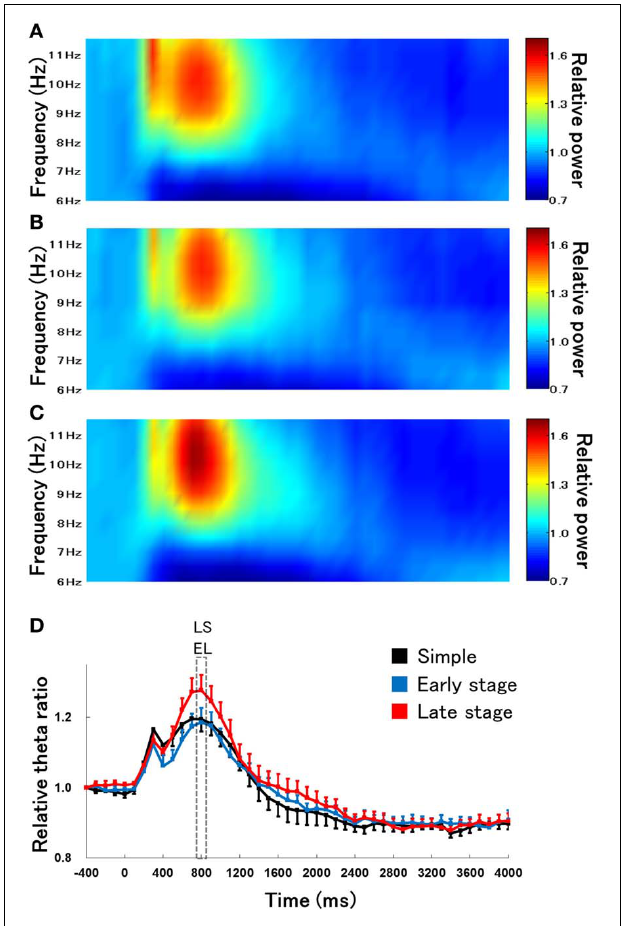
FIGURE 5 | The relative change in hippocampal theta power during non-RFTs of the retention test for the simple discrimination task (A), the early learning stage (B), and the late learning stage (C) of the FN task. The 0-ms period indicates the onset of the stimulus presentation. The X-axis is time (ms) and the Y-axis is frequency (Hz) in panels (A–C) . The period was divided into 45 sub-periods of 100ms each. The mean hippocampal theta power from 500 to 400ms before the stimulus onset was counted as the − 400-ms period (no stimuli were present and no rats pressed the lever during this period), and the relative theta power calculated for each period was normalized to that of the − 400-ms period (relative theta power of each period = theta power of each period/theta power at the − 400-ms period). Panel (D) depicts the mean hippocampal theta power between 6 and 12Hz (Simple: simple discrimination task; Early stage: early learning stage of the FN task; Late stage: late learning stage of the FN task). The “ES” indicates a significant difference between the early learning stage of the FN task and the retention test for the simple discrimination task (ES: p < 0 . 05 ), “EL” indicates a significant difference between the early learning stage and the late learning stage of the FN task (EL: p < 0 . 05 ), and “LS” indicates a significant difference between the late learning stage of the FN task and the retention test for the simple discrimination task (LS: p < 0 . 05 ). Error bars indicate